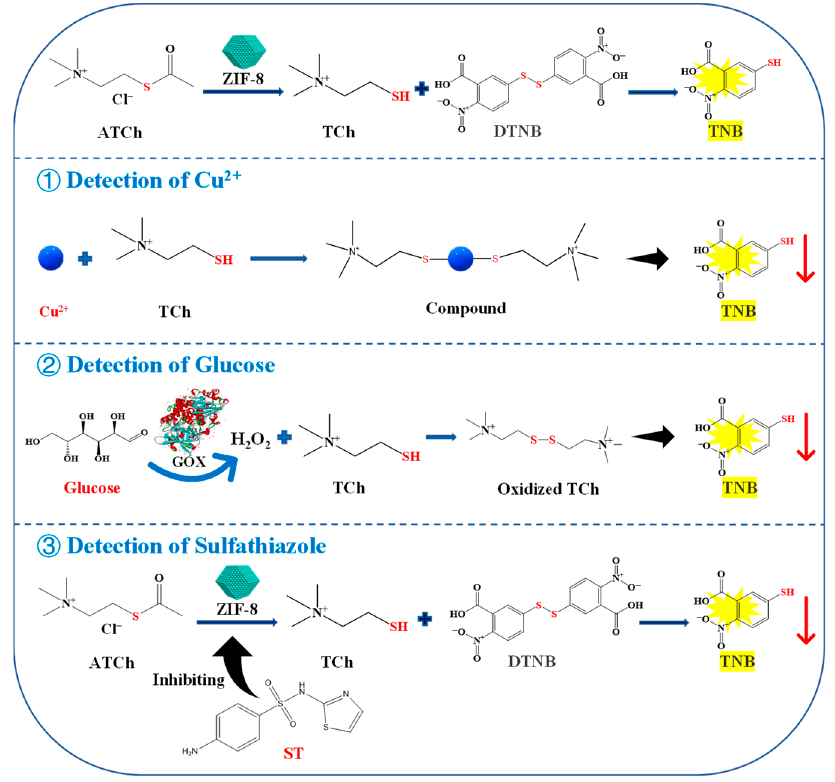
Figure 1. Schematic illustration for the detection of Cu 2+ , glucose, and ST based on the AChE-like activity of ZIF-8. ATCh, acetylthiocholine chloride; TCh, thiocholine; DTNB, 5,5 ′ -dithiobis-(2-nitrobenzoic acid); TNB, 5-dithiobis nitrobenzoic acid; ST, sulfathiazole.